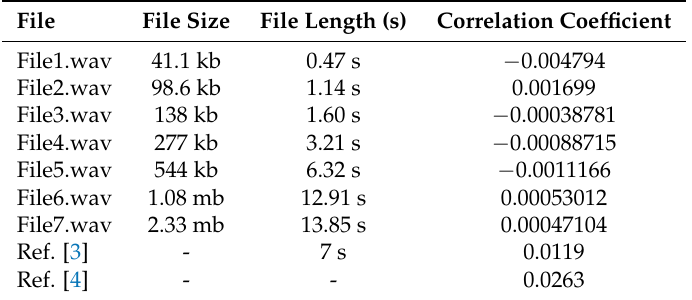
Table 4. Correlation between plain and encrypted audio files.